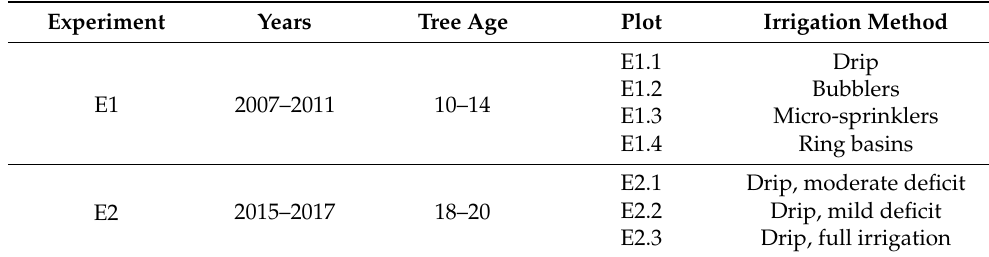
Table 1. Experiments reported in this study.